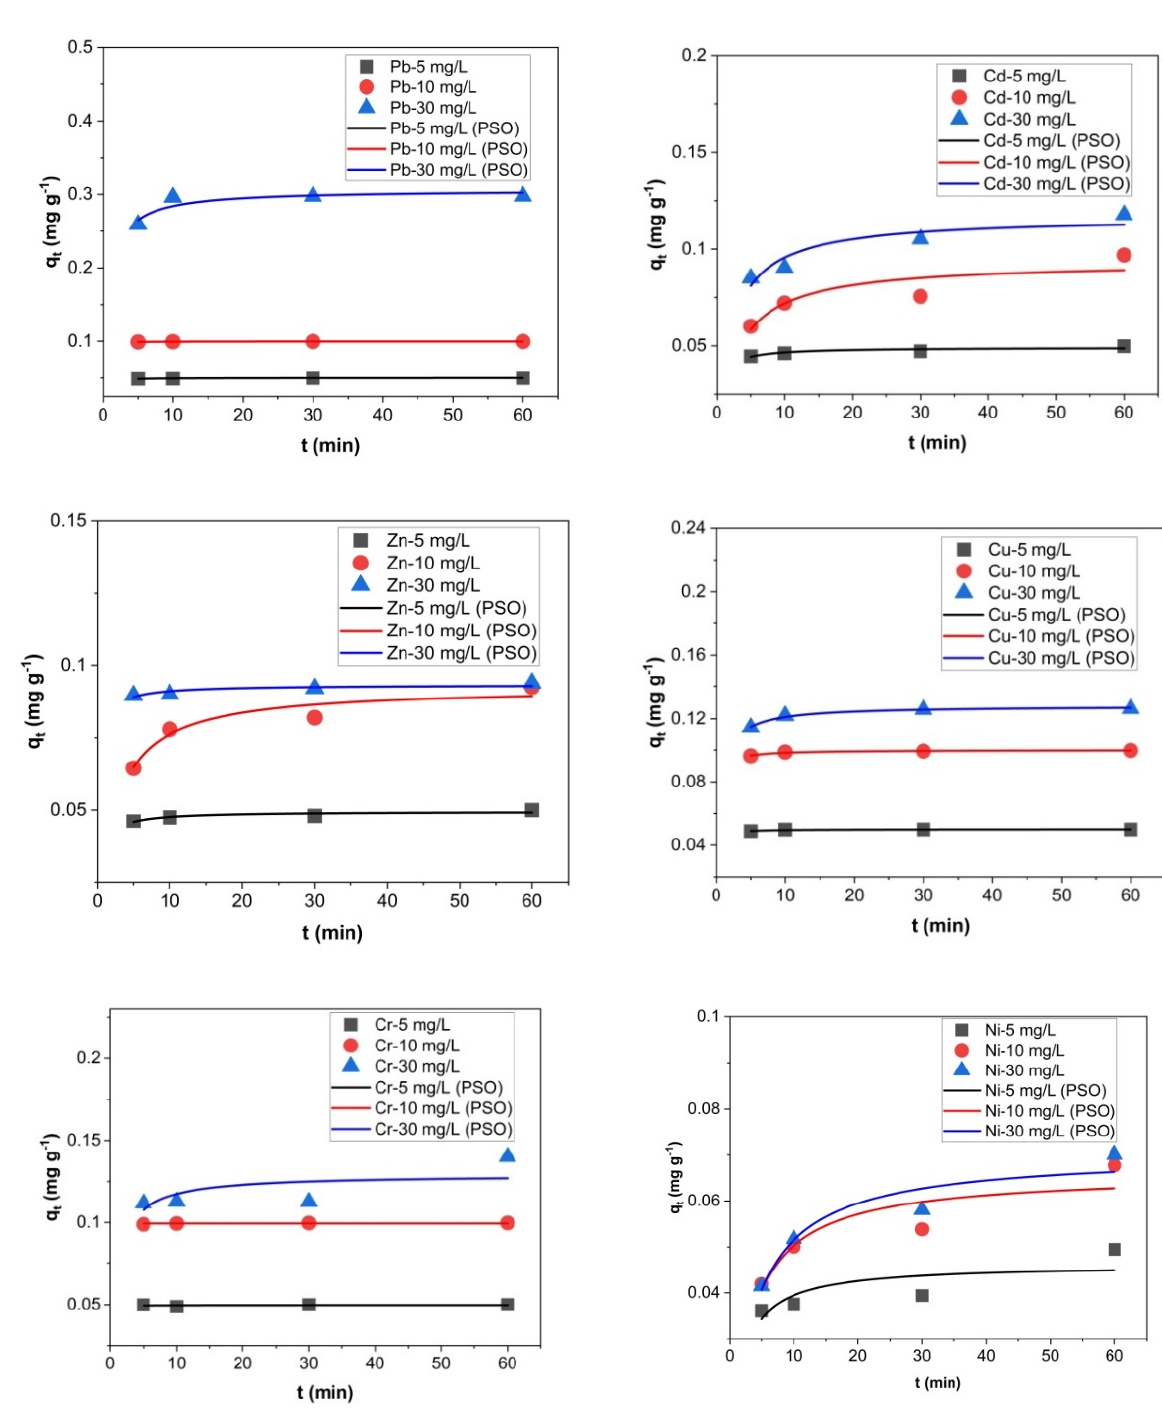
Figure 10. Nonlinear fitting of PSO for Pb, Cd, Zn, Cu, Cr and Ni ions sorption onto zeolite with a 0–0.05 mm particle size thermally treated at 200 °C. Table 5. PFO and PSO kinetic parameters for Pb, Cd, Zn, Cu, Cr, and Ni ions sorption onto zeolite with a 0–0.05 mm particle size thermally treated at 200 °C.